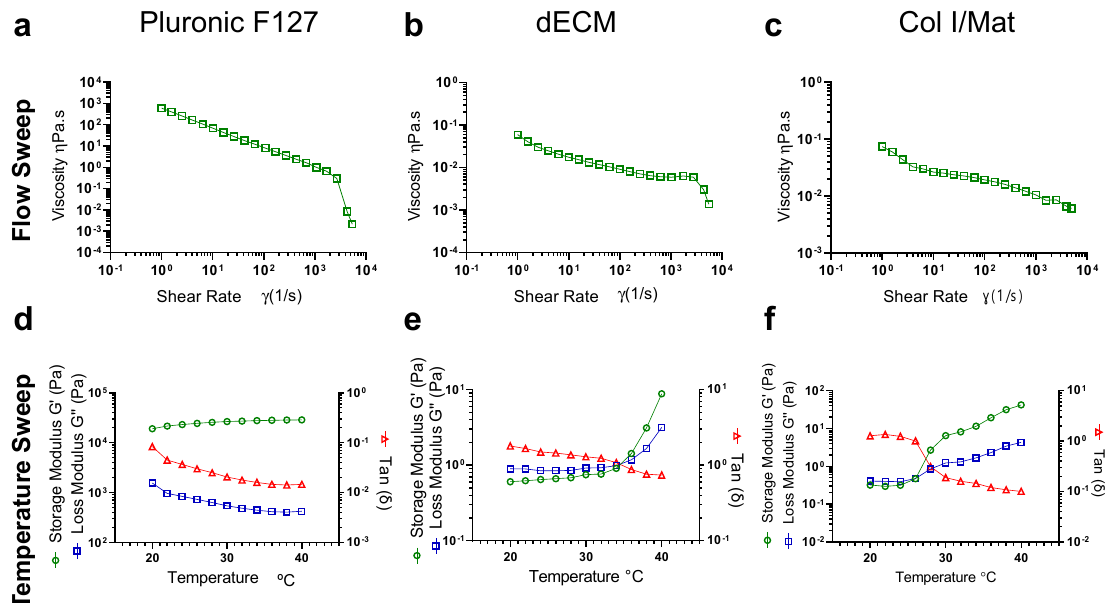
Figure 3. Rheological properties of the dECM and collagen I/Matrigel materials. ( a – c ) Flow sweep and ( d – f ) temperature sweep experiments were performed on dECM (20 mg mL − 1 ) and collagen I/Matrigel (Col I/Mat) versus 25% Pluronic F127. Experiments were carried out on a DHR3 Rheometer (TA Instruments), with dECM materials pre-warmed at 37 °C and neutralized with 1 N NaOH and 10X PBS and with Col I/Mat materials cooled at 4 °C and neutralized with 1 N NaOH. Pluronic F127 data represents the average of four repeat experiments. dECM data represents the average of three independent experiments. Col I/Mat represents the average of two independent experiments.